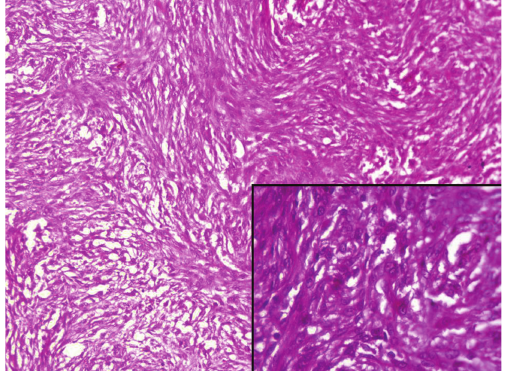
Figure 5: Section showing tumor cells focally positive for CD34 (10x, CD34